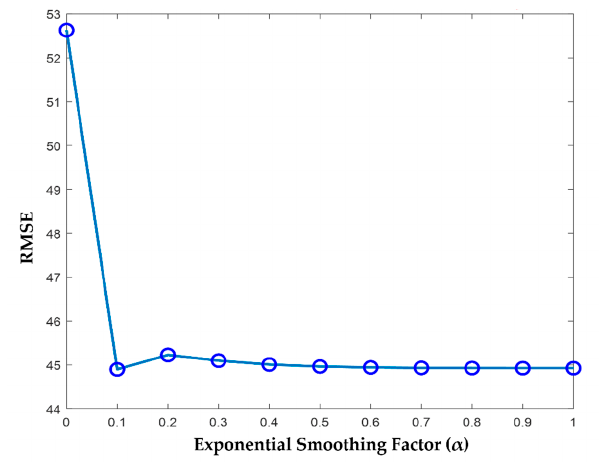
Figure 8. Variation of RMSE on U g when smoothing parameter, α is varied.